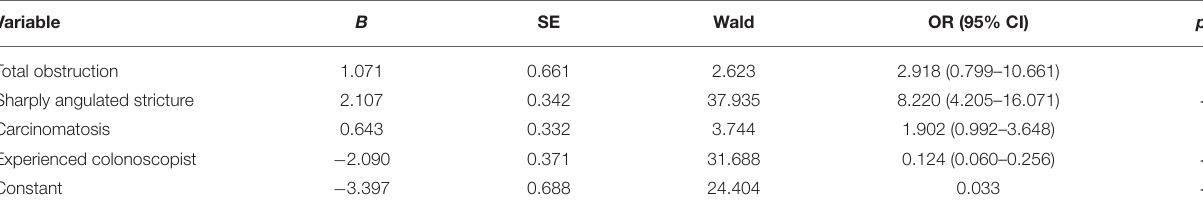
TABLE 3 | Independent predictors for the failure of guidewire insertion by multivariate analysis. Variable